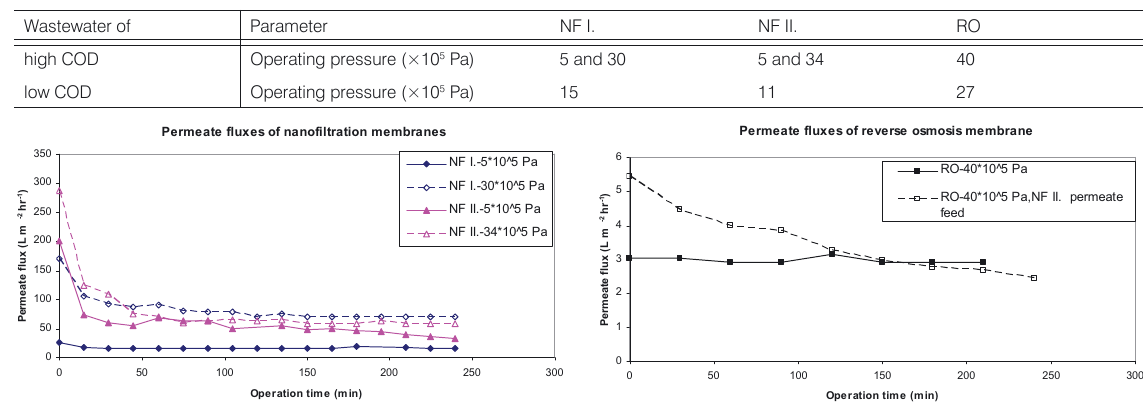
Figure 2. Permeate fluxes of NF membranes vs. operation time (wastewater of high COD).